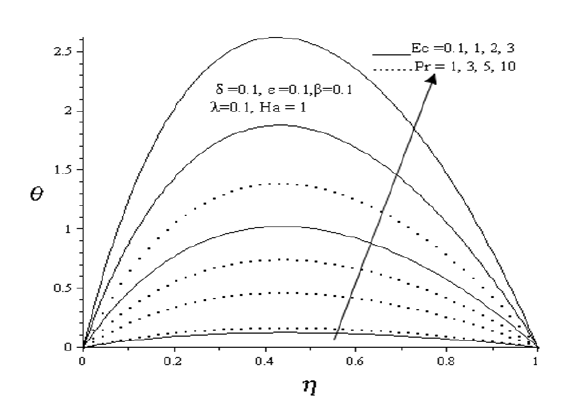
Figure 7. Steady state temperature profiles with increasing Ec and Pr